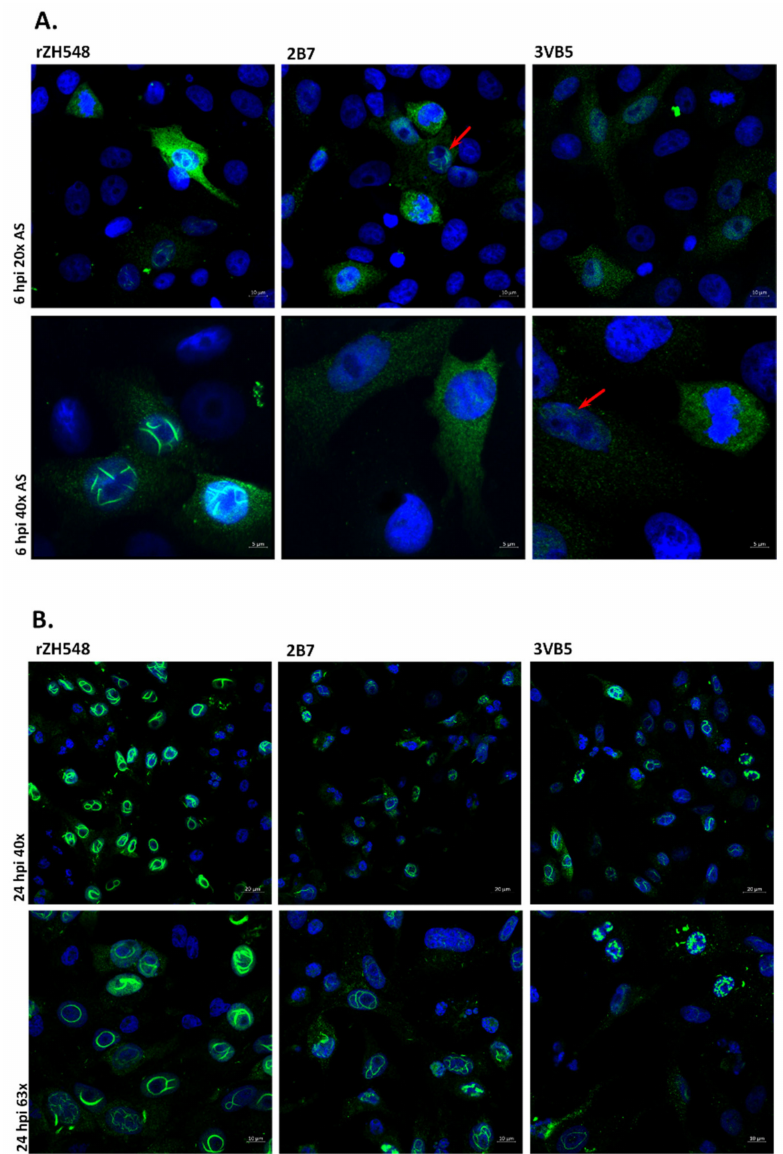
Figure 3. Localization and filament formation of wt and mutant NSs proteins. Vero cells were infected with rZH548 and the two rZH548-P82L mutants at a MOI of 1. At 6 (panel A ) and 24 (panel B ) hours pi, cells were fixed and subjected to indirect immunofluorescence with the anti-NSs monoclonal antibody 5C3A1B2. Nuclei were stained with DAPI. For each virus and time pi, 2 images with different magnification are shown as indicated. AS denotes Zeiss Airyscan 2D superresolution mode. Red arrows in panel A point to cells infected with the rZH548-P82L viruses where nuclear filaments could be detected. Scale bars: 20 µ M (upper panel B), 10 µ M (upper panel A and lower panel B ); 5 µ M (lower panel A